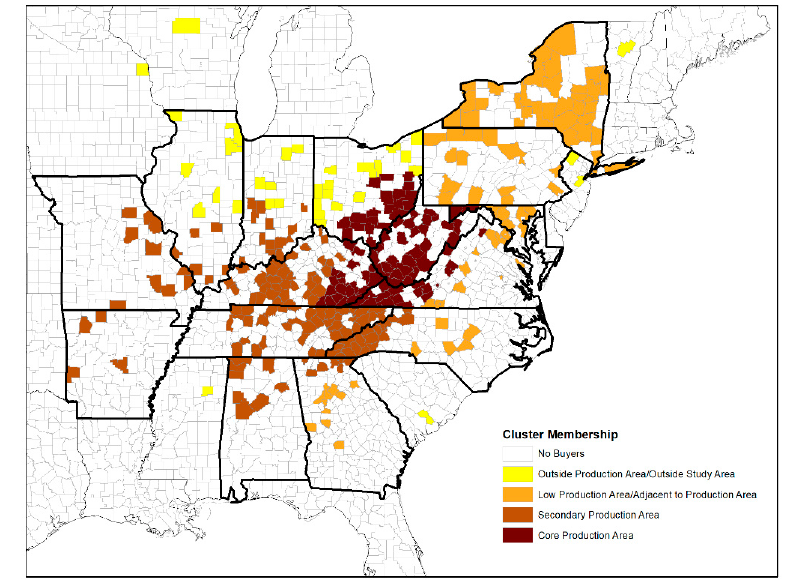
Figure 2. Map of cluster membership for US counties containing ginseng buyers registered in the study area (states outlined in bold) based on significant variables in a multinomial logistic regression predicting off-root buying behavior. Clusters are classified as the Core Production, Secondary Production, Low Production and Outside/Adjacent. Buyers were also located in five west coast counties, which are also classified as Outside/Adjacent.